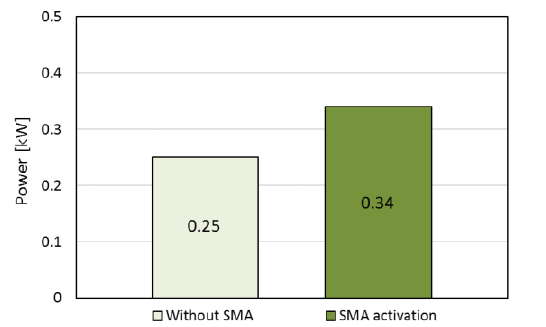
Fig. 13. Rotor lock and hover